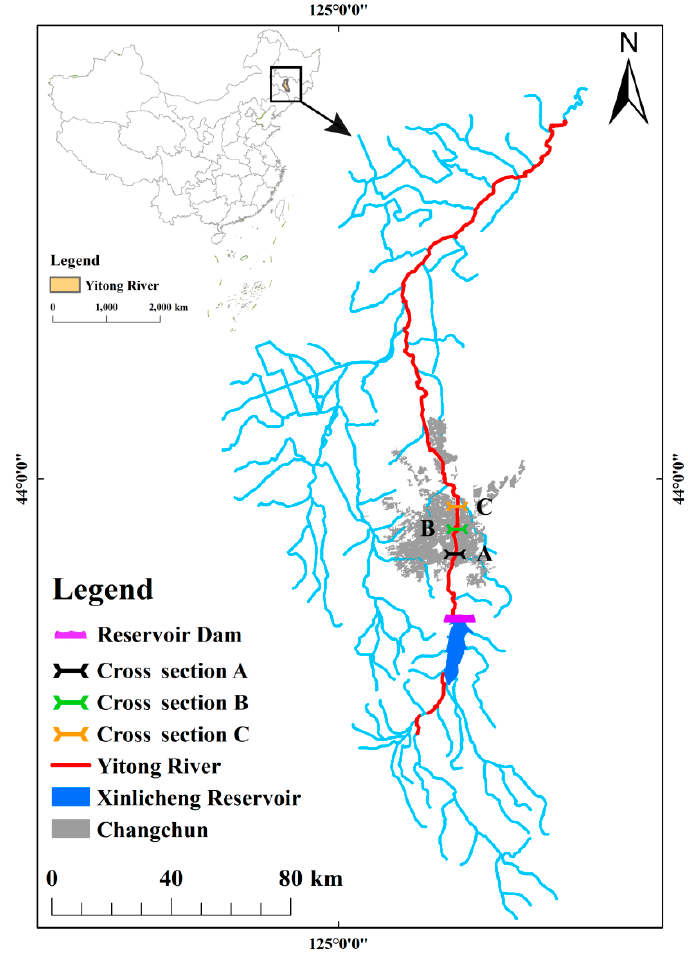
Figure 1. Location of the study area.